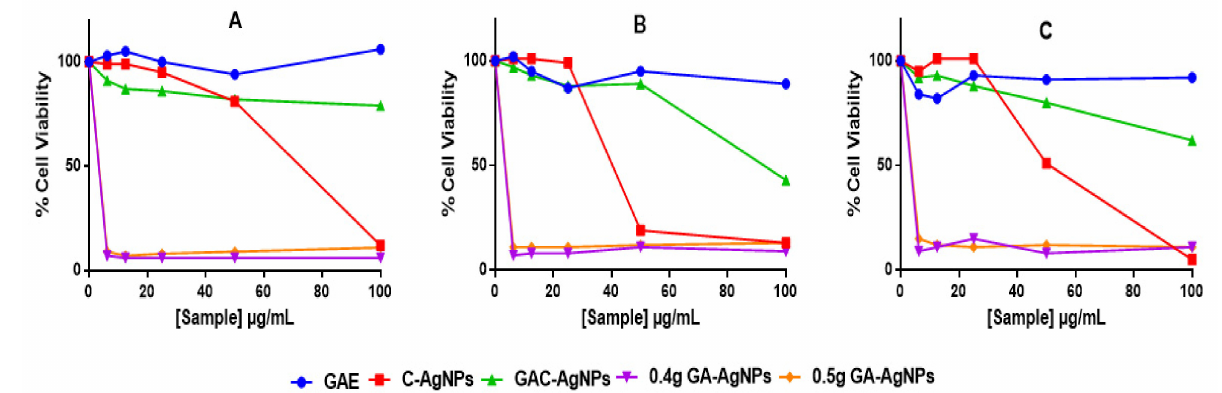
Figure 7. Cytotoxicity of the GAE, C-AgNPs, GAC-AgNPs and GA-AgNPs on KMST-6 ( A ), Caco-2 ( B ) and HT-29 ( C ) cells.